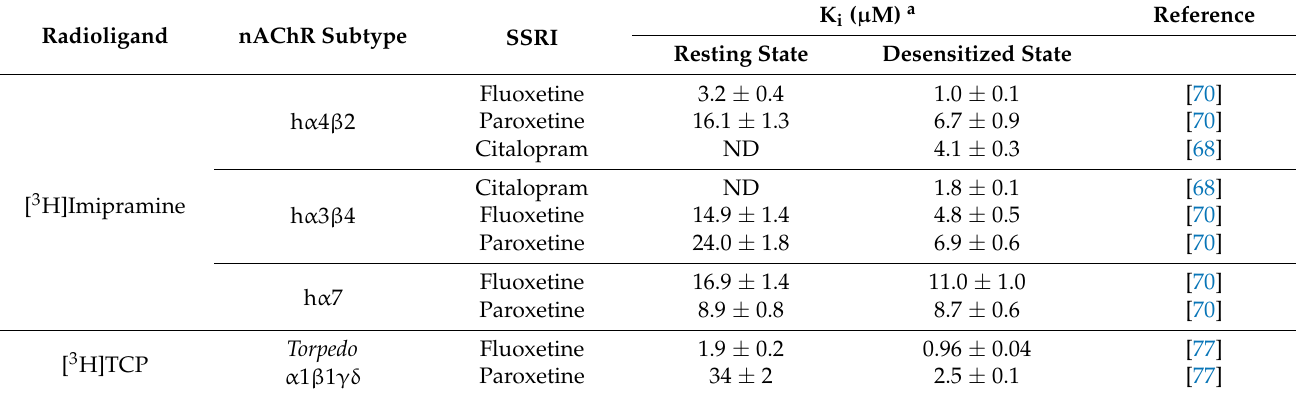
a The inhibition constant (K i ) represents the ligand affinity for the tested radioligand binding site(s) in the desensitized (agonist-bound) and resting (bungarotoxin-bound) states, respectively. h,